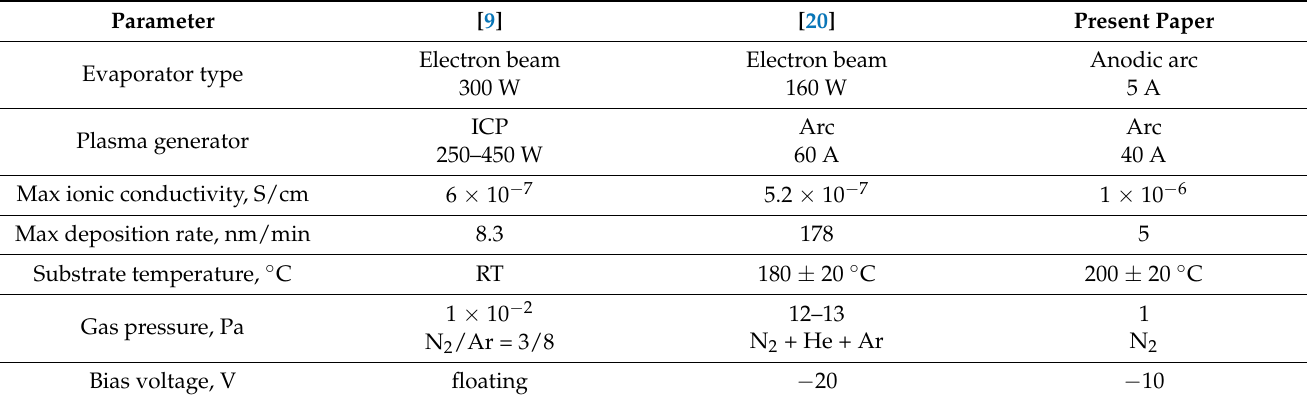
Table 1. The comparative characteristics of deposition